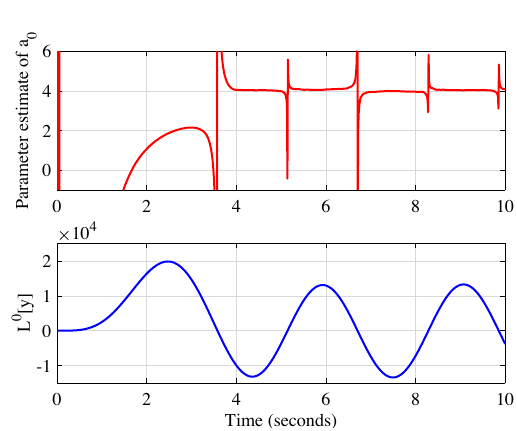
Figure 4: Parameter estimate ˆ a 0 (top) and operator L 0 [ y ] (bottom) for the oscillator example